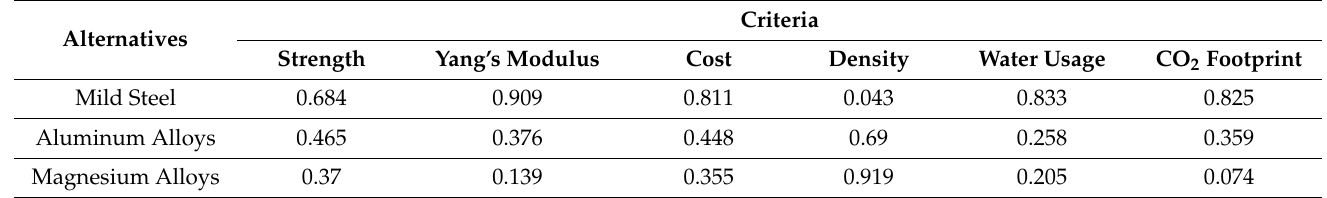
Figure 11. Extracting decision-relevant information from the plot of cost versus density.